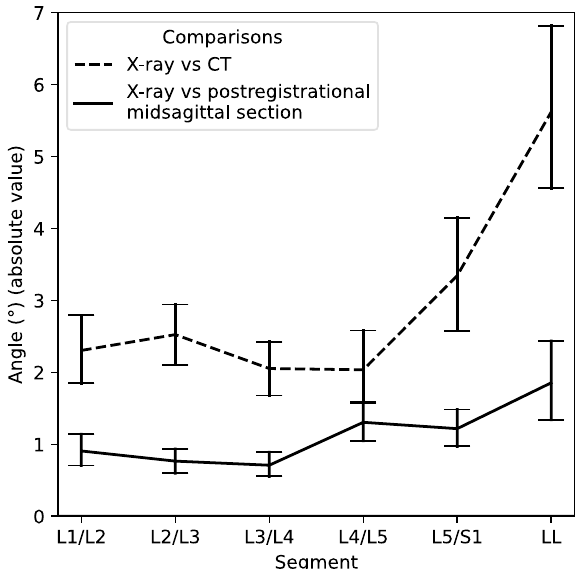
Figure 7. Average absolute value differences in degrees between intersegmental and LL angles measured in postregistrational midsagittal sections and standing radiographs, compared to the previous measurement (between X-rays and CTs). Error bars indicate 95% confidence